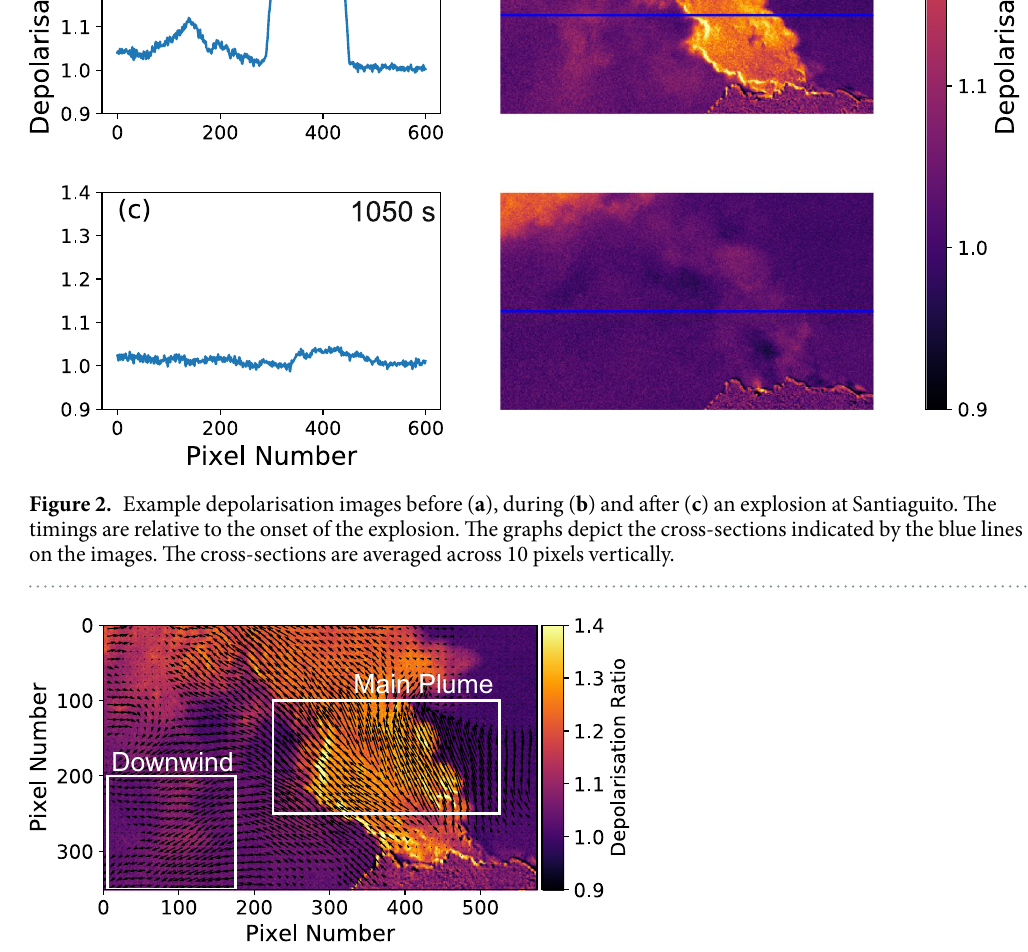
Figure 3. Example flow map of the output from the optical flow 275 s after the onset of the explosion. The length of the arrows is proportional to the flow speed. The white boxes show the main plume and downwind areas chosen for further